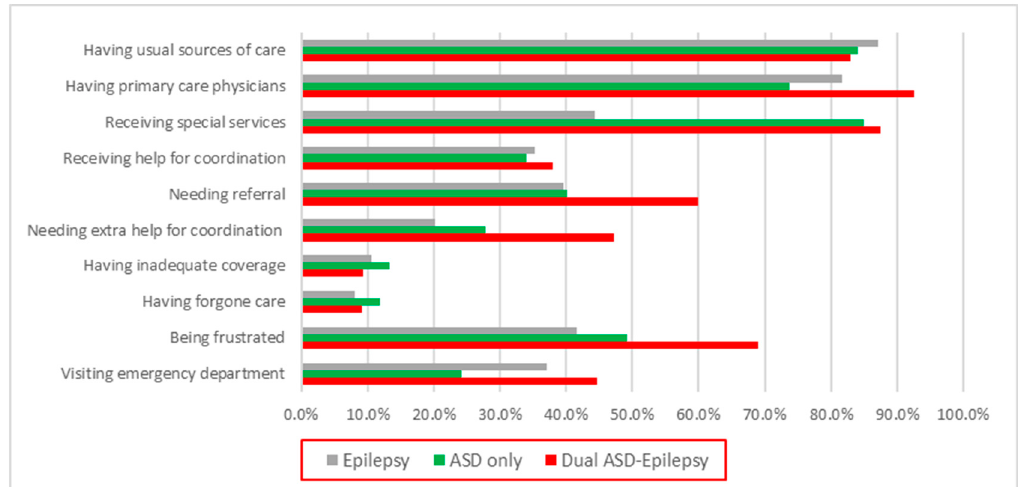
Figure 1. Ten access indicators among 3 groups. ASD: autism spectrum disorder.